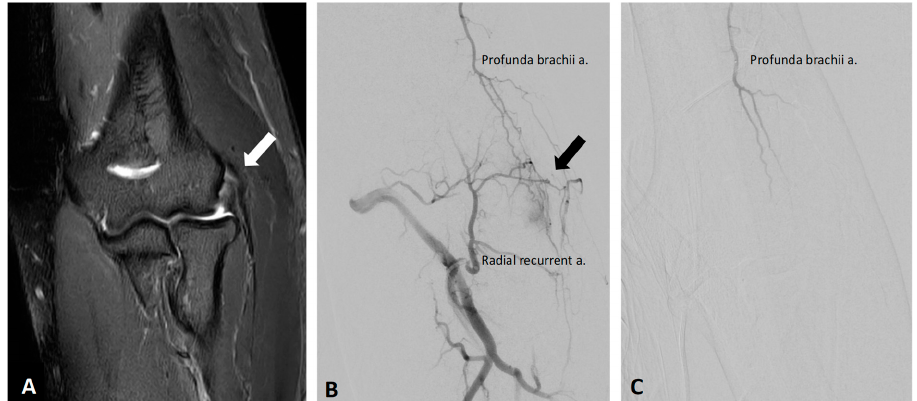
Figure 4. Representative pre- and postprocedural images of the right elbow lateral epicondylitis in a 58-year-old male. ( A ) Preprocedural coronal MRI (fat-saturated T2-weighted image) revealed abnormal thickening with elevated signal intensity within the common extensor origin from the lateral epicondyle (white arrows). ( B ) Preprocedural angiography of the right radial recurrent artery showed angiogenesis with reflux to profunda brachii artery (black arrows) over the corresponding enhanced region of MRI. ( C ) Postembolization angiography via profunda brachii artery and other arteries indicated the elimination of angiogenesis after TAE. The patient’s lateral elbow pain and function both were improved after TAE.